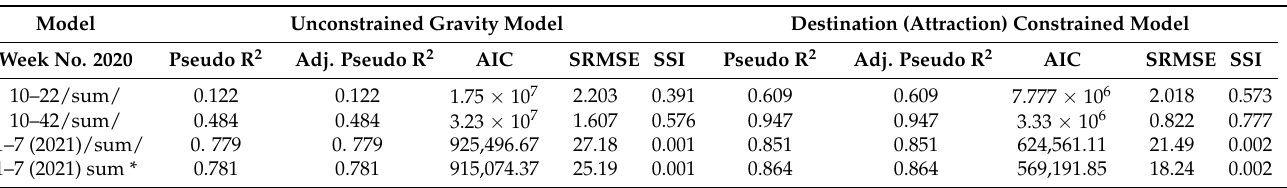
Table 3. Spatial interaction model fit statistics (for different time intervals in the early stages of the outbreak).